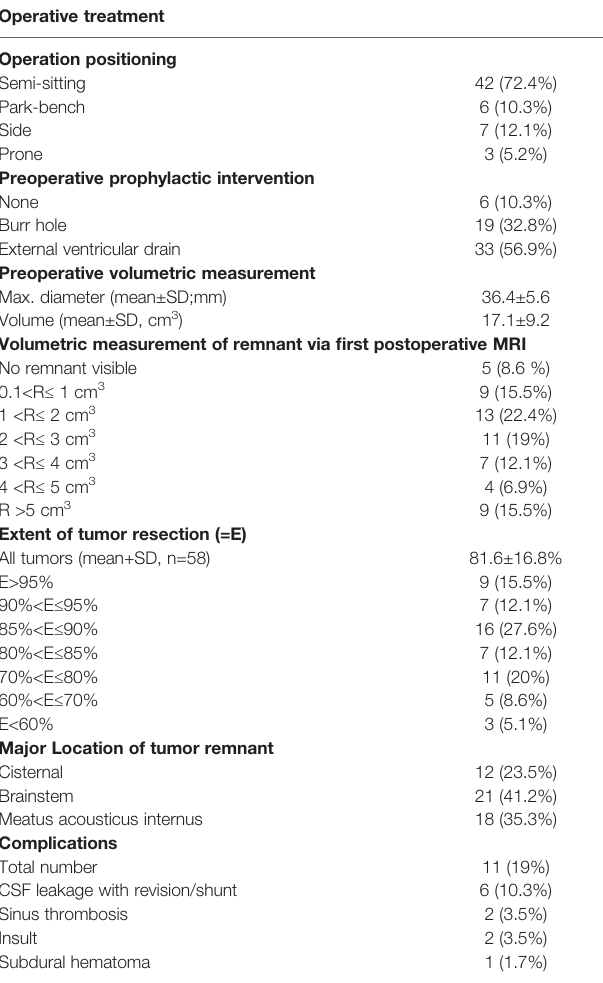
TABLE 2 | Operative treatment and anatomic outcome at discharge. Operative treatment Operation positioning